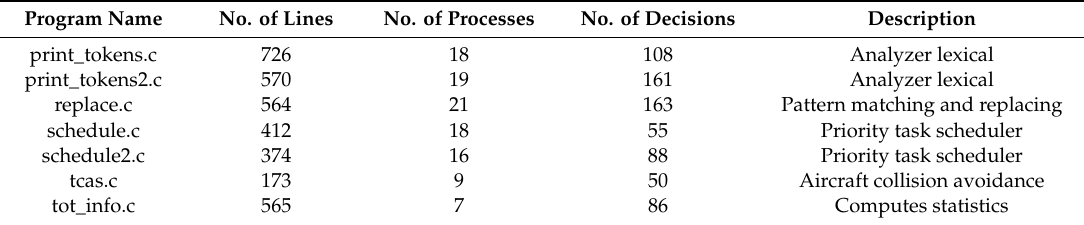
Table 2. Detail of the tested program Siemens